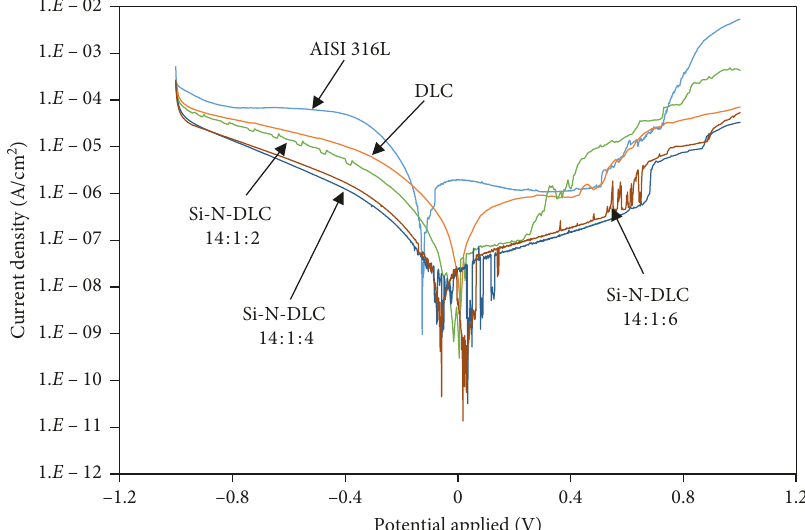
Figure 10: Potentiodynamic polarization curve of uncoated AISI 316L pure DLC and Si-N-DLC films.